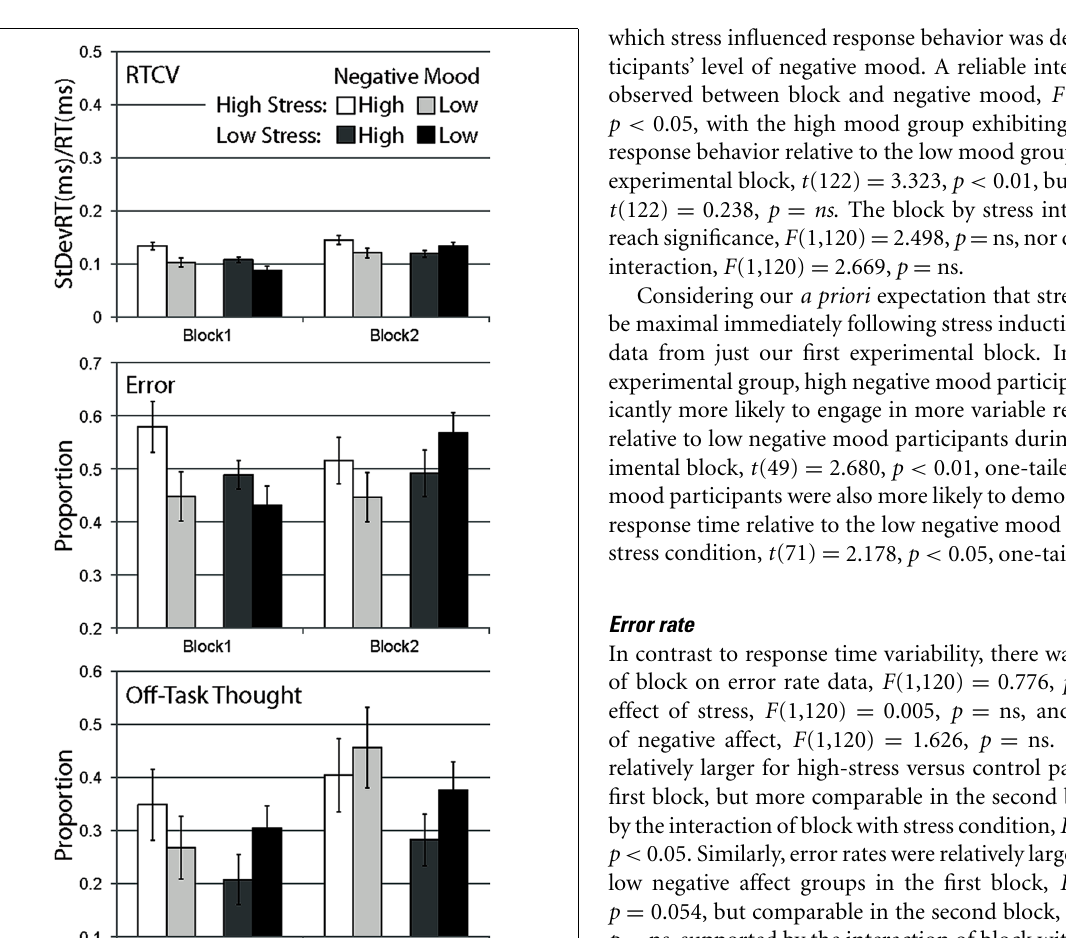
that are likely to diminish over time. Mean data are shown in Figure 1